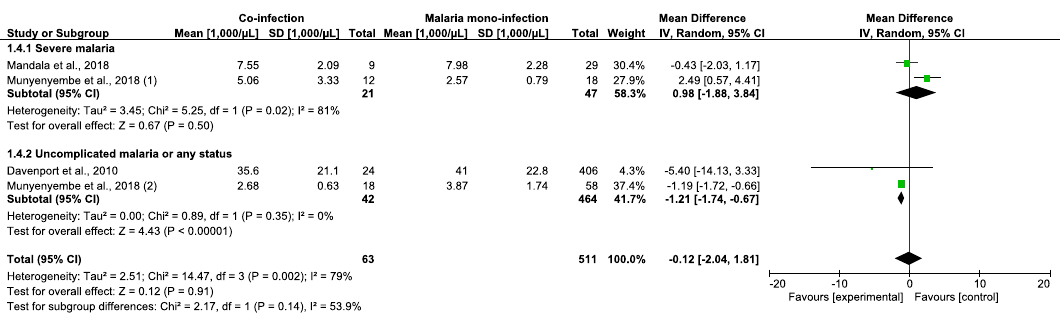
Figure 6. The pooled MD of neutrophil counts between Plasmodium spp. and HIV co-infected and Plasmodium spp. patients.